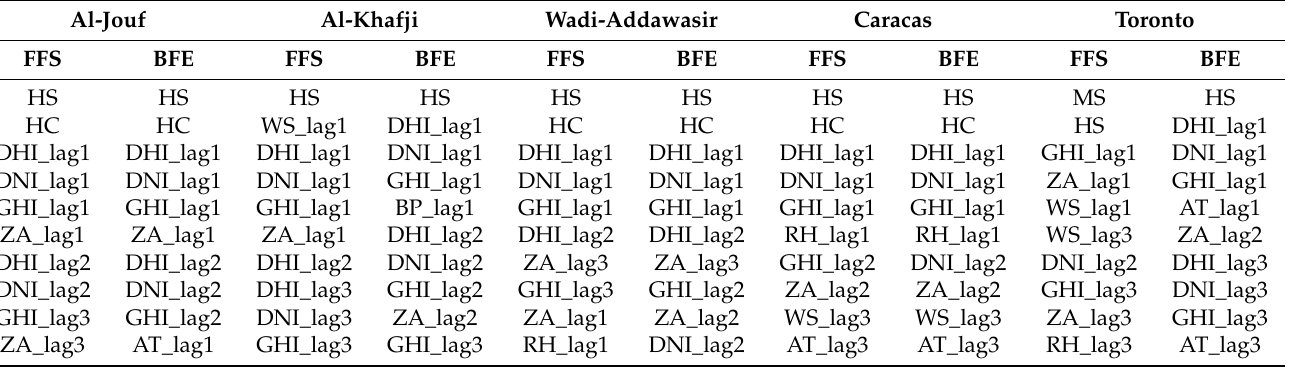
Table 8. Selected features by FFS and BFE .